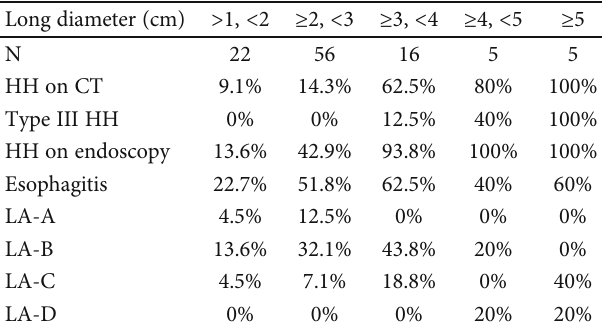
Figure 3: 3D reconstruction of esophageal hiatus from CT images of Figure 2: (a) anteroposterior view of reconstructed vertebra, ribs, and esophageal hiatus; (b) objectively measured long diameter of esophageal hiatus, Table 1: HH and esophagitis according to di ff erent degrees of gastroesophageal laxity.